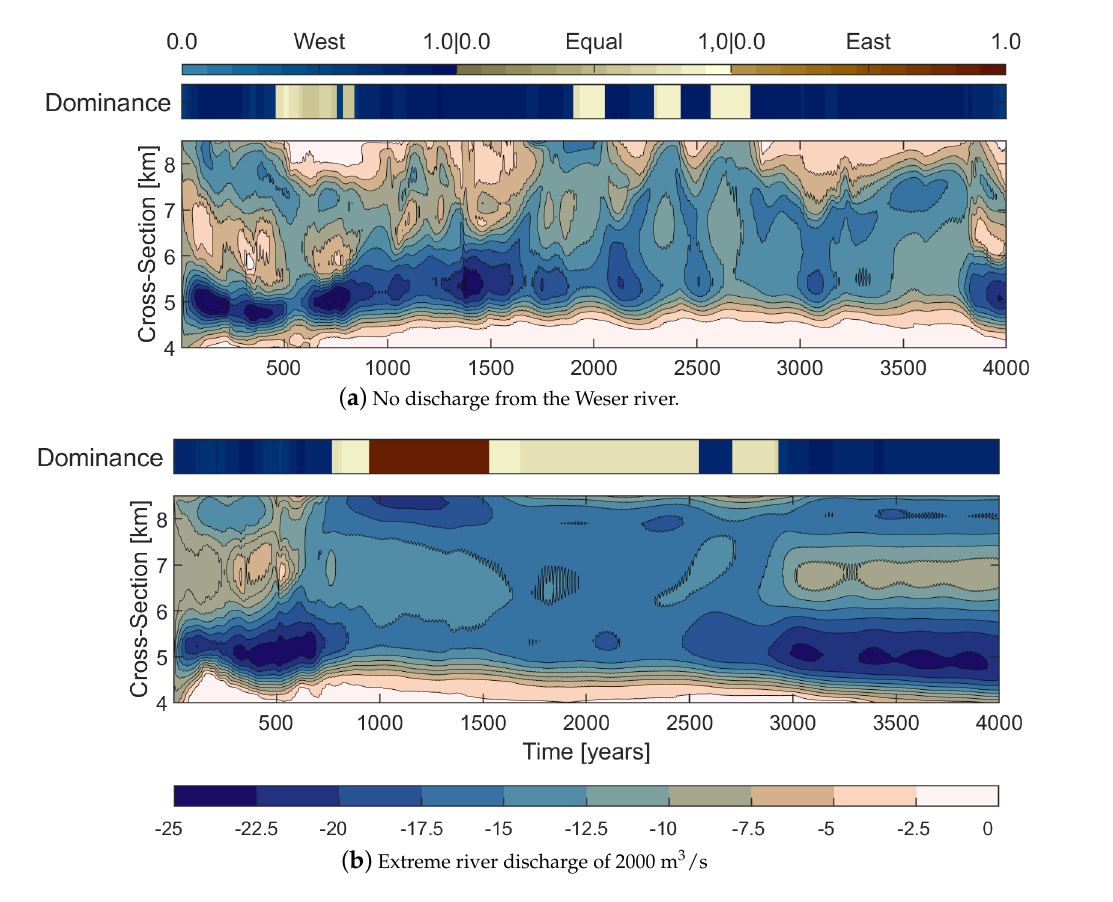
Figure 9. Alternation of the two-channel system for the river discharge scenario simulations (description, see Figure 7). Accordingly, the alternation is relatively slow for both cases, especially for the extreme discharge scenario. Here, the CASE method indicates that there is one full alternation of channel dominance only in 4000 years. The cross-sectional plot supports this finding as described previously. In the no discharge scenario, some alternating features can be found even though the dominance does not fully alternate. Additionally, due to general orientation of the channels toward the west in combination with the established channel on the western side, a clear alternation is seen from 1750 to 3000 years. This observation is supported by the recurrent pattern in the cross-correlation revealed by the CASE